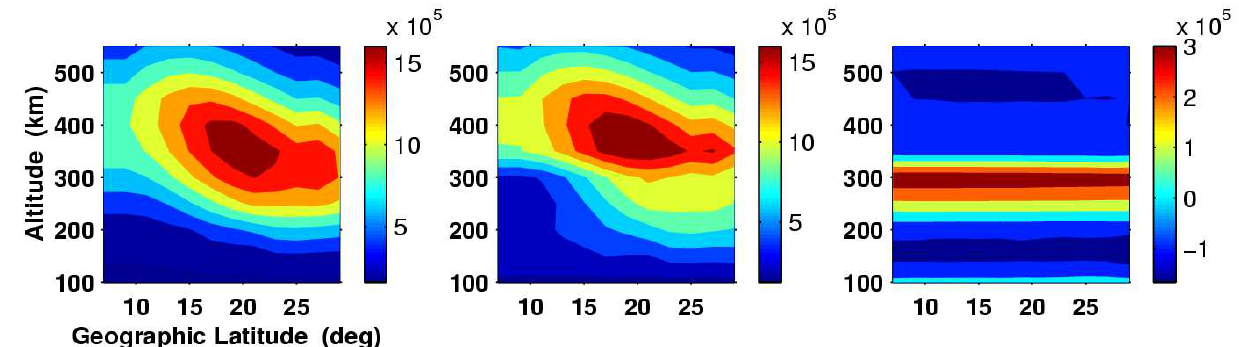
Fig. 8. ( a ) The model ionosphere for error analysis. ( b ) The reconstructed image, with a bias error of 1% of the minimum TEC when the 3 smallest singular values are omitted from the solution. ( c ) The difference from the